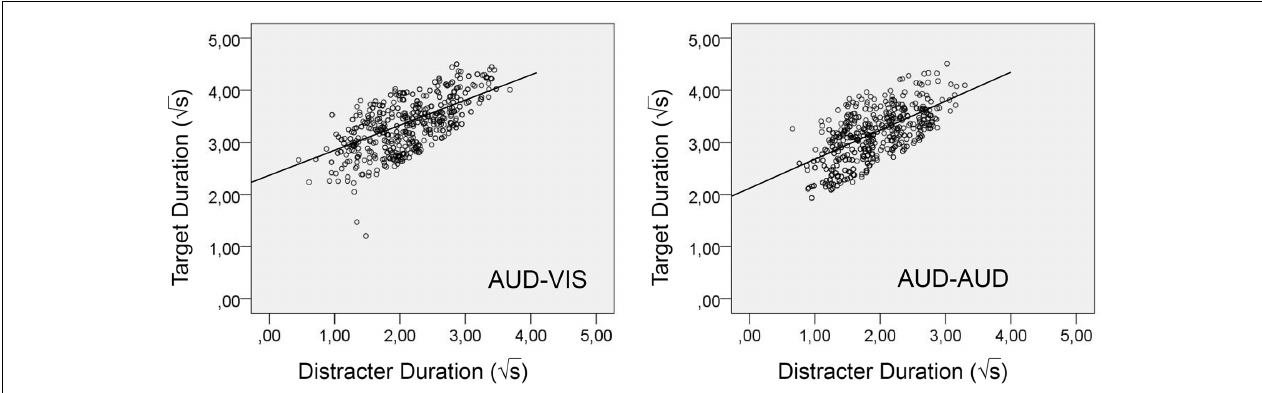
obtained from Experiment 2. Left panel: Data obtained from Condition AUD–AUD; right panel: Data obtained from Condition AUD–VIS.The straight line indicates the least-square regression line.